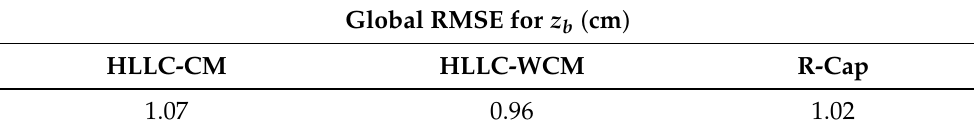
Table 4. Global RMSE for the bed level z b with the HLLC-CM, HLLC-WCM, and R-Cap.